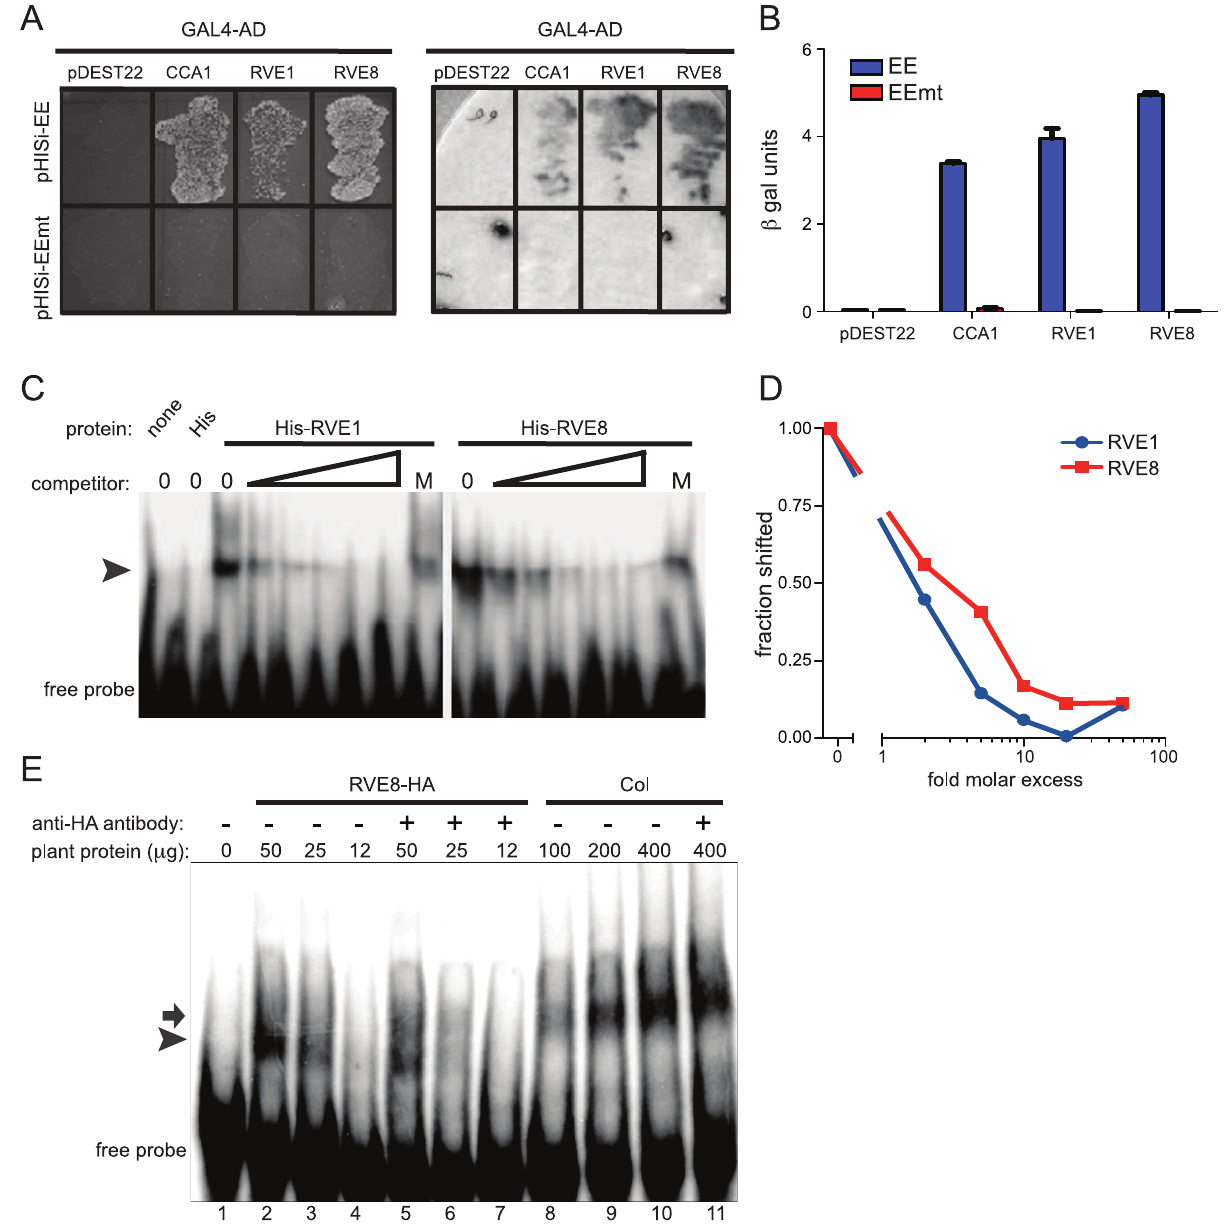
Figure 2. RVE8 binds specifically to the EE both invivo and invitro . (A, B) Four copies of wild-type or mutant EE were multimerized and used to drive expression of the HIS3 or lacZ genes in S. cerevisiae . The CCA1, RVE1, and RVE8 cDNAs were fused to the GAL4 activation domain, transformed into yeast containing the above bait vectors, and plated on media lacking histidine (A, left panel). They were also assayed for b -galactosidase activity on a filter (A, right panel) and in a liquid assay (B). (C) Recombinant RVE1 or RVE8 was incubated with a multimerized, radiolabeled, EE probe sequence. A 2, 5, 10, 20, or 50-fold molar excess of unlabeled EE or a 50-fold molar excess of unlabeled mutant EE (indicated by the letter M) was added to each reaction as competitor. Protein/DNA complexes were separated on a non-denaturing polyacrylamide gel and the radiolabeled DNA visualized using a phosphorimager. The arrowhead indicates the position of protein/DNA complexes. (D) The fraction of probe shifted in each lane was quantified and normalized to the fraction shifted in the lane with no added competitor. (E) An EMSA assay was performed with protein extracted from wild-type or plants overexpressing HA-tagged RVE8. 1 m g of anti-HA antibody was added to some reactions, as indicated. The arrow indicates the mobility of the shifted DNA/protein complex using extracts made from wild type while the arrowhead indicates the mobility of the complex using extracts made from plants overexpressing RVE8 . Data are representative of three independent experiments.